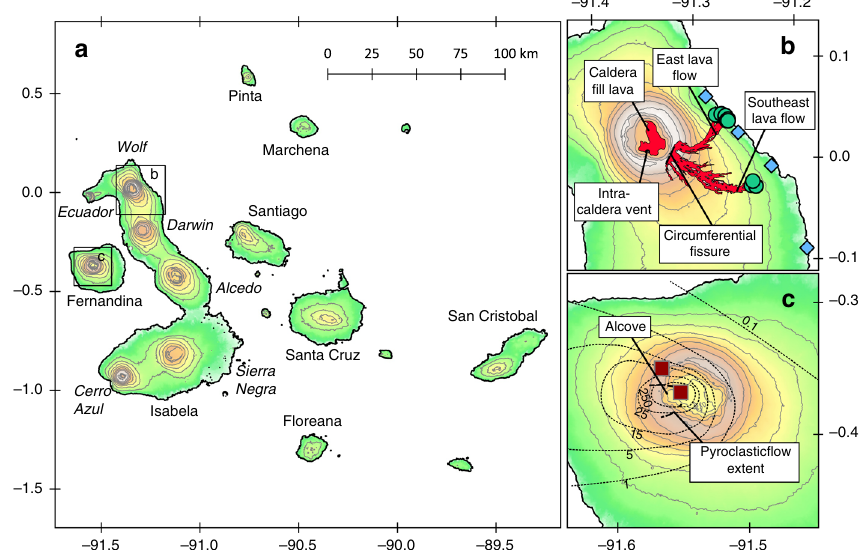
Fig. 1 Locations of Wolf and Fernandina volcanoes and the sampling sites in this study. a Regional map of the Galápagos Archipelago showing the different volcanic centres on Isabela Island. Boxes show the locations of maps ( b ) and ( c ). b Detailed map of Wolf volcano showing the locations of the 2015 circumferential fi ssure and intra-caldera vent. The 2015 lava fl ow extent is in red, after Bernard et al. 71 . The sampling locations of the lavas and tephra analysed in this study are shown as green circles and blue diamonds, respectively. c Detailed map of Fernandina showing the extent of the pyroclastic fl ow (dashed line) and isopachs of the total tephra (in cm; dotted lines) produced during the 1968 eruption, after Howard et al. 48 . The sampling locations of the nodules analysed in this study are shown as dark red squares. Contours are 200